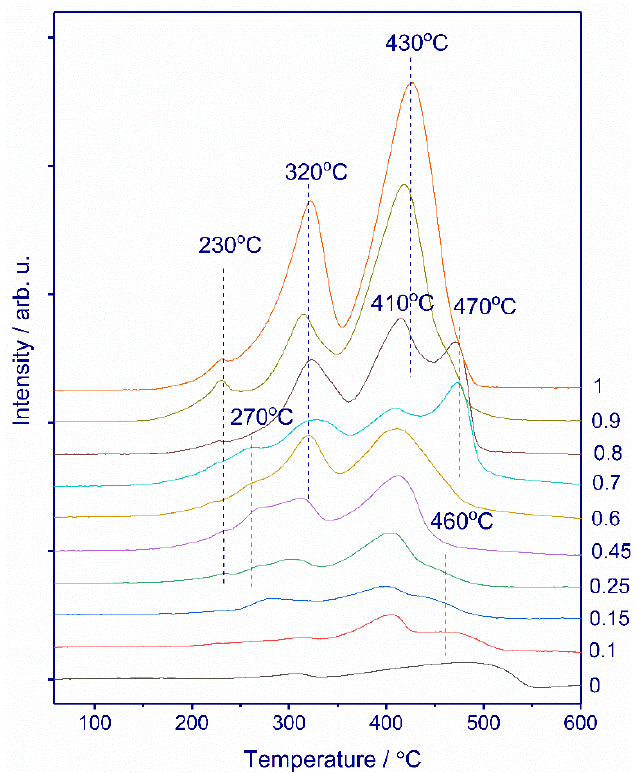
Figure 6. TPR-H 2 profiles of MnxCe1 − x catalysts.